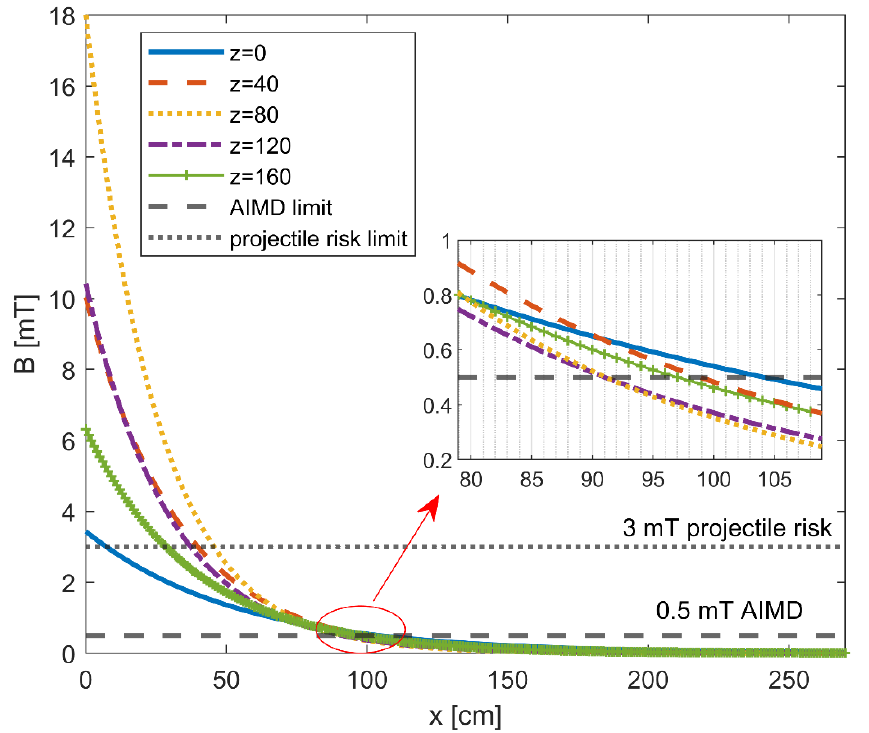
Figure 2. Modulus of the magnetic flux density | B | along a linear trajectory parallel to the x -axis starting close to the NMR spectrometer (x = 0 cm) and moving toward the console position (x = 270 cm) at different heights with respect to the floor.